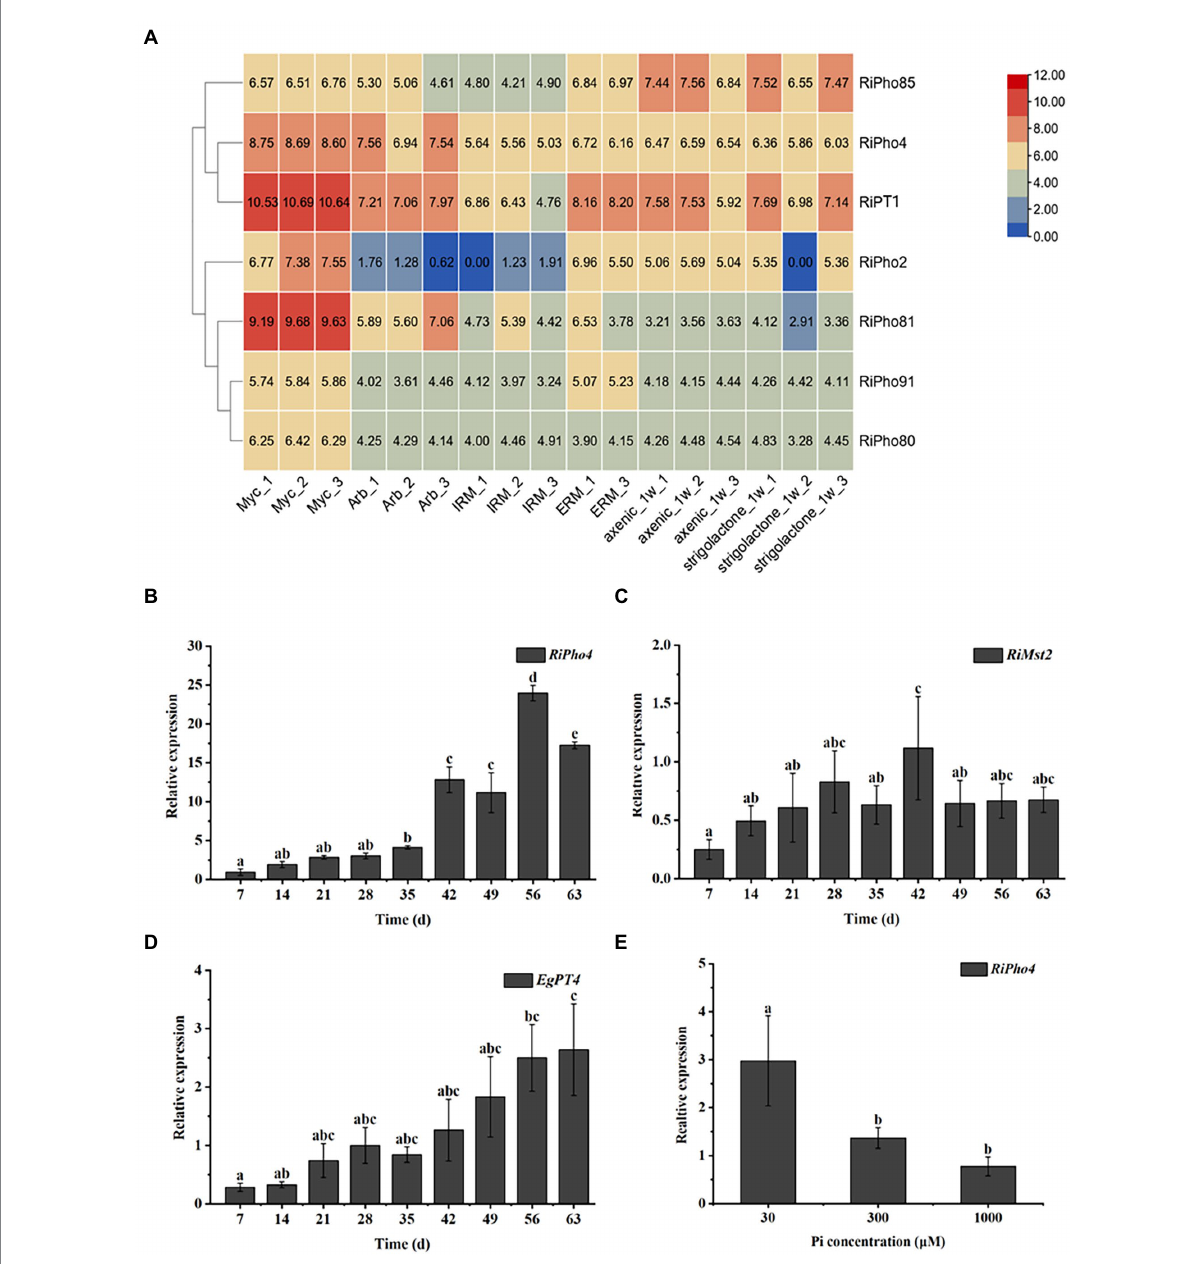
FIGURE 4 Spatiotemporal expression patterns of RiPho4 from the AM fungus R. irregularis . (A) Analysis of the heat diagram for transcriptional levels of RiPho4 and some PHO pathway genes in different fungal tissues: mycorrhizal roots of Medicago truncatula (Myc), arbuscules from M. truncatula mycorrhizal roots (Arb), intraradical mycelium (IRM), extraradical mycelium (ERM), axenic germinating spores harvested at a week after inoculation (axenic_1w) and germinating spores at 7 days after GR24 induction (strigolactone_1w). The heatmap of identities was visualized by the TBtools (Chen et al., 2020). (B–D) Time-course assay of the expression of RiPho4 , RiMst2 and EgPT4 in E. grandis mycorrhizal roots after 7, 14, 21, 28, 35, 42, 49, 56 and 63 days (d) inoculation with R. irregularis . RiEF1 α and EgUBI3 were used as the reference genes for R. irregularis and E. grandis gene normalization, respectively. (E) Expression analysis of RiPho4 in mycorrhizal roots of E. grandis grown under different phosphate concentrations. The error bars are the means with standard errors of three biological replications. Treatments with the same letters do not differ from others by the Duncan’s test at 5%